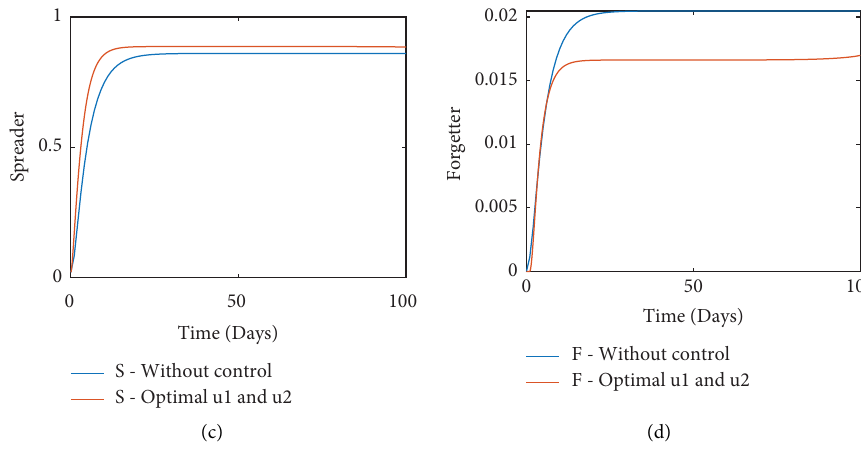
Figure 15: Comparison of population density with u